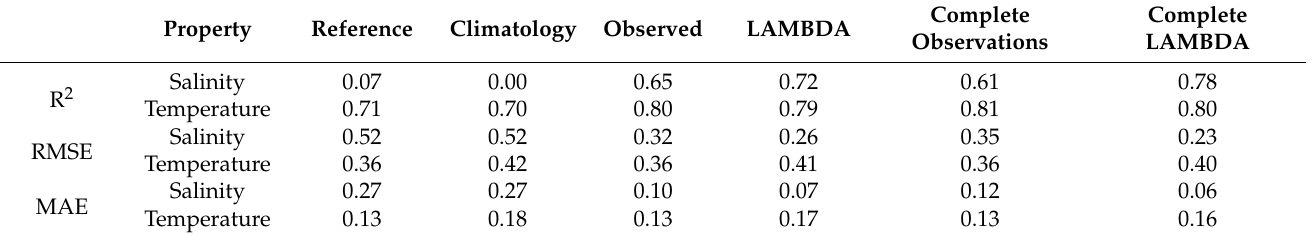
Table 3. Surface salinity and temperature coefficient of determination (R 2 ), Root Mean Square Error (RMSE) and Mean Absolute Error (MAE) between the observations of Silleiro buoy and each PCOMS configuration using LAMBDA boundary conditions scenario for the period of 1 January–4 January 2018. The Complete scenarios are the only ones using the proxy.